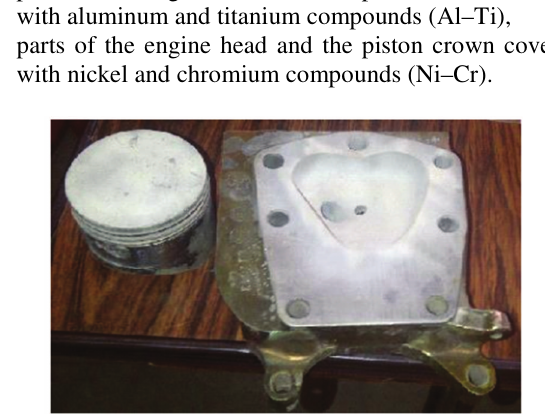
Fig. 1. The elements of engine covered by means of plasma spraying